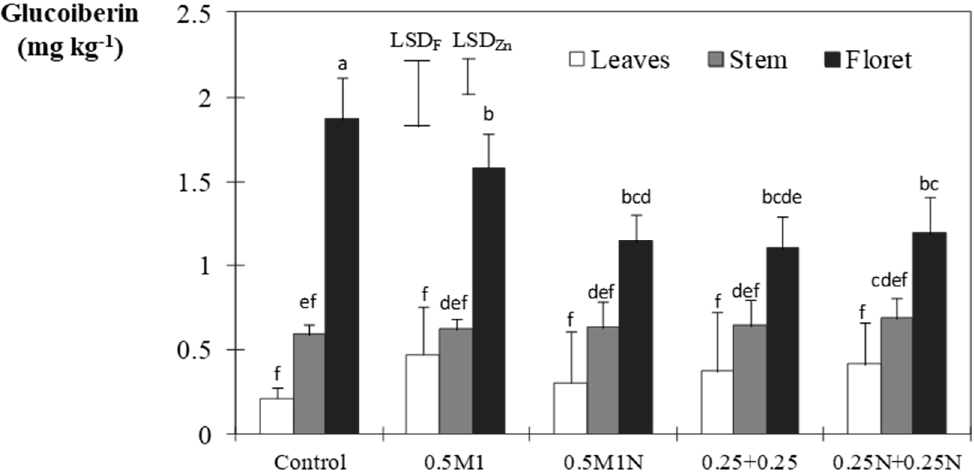
Figure 3. Glucoiberin ± standard error of the mean. Vertical bars represent LSD ( p < 0.05) for comparison. LSD F : same broccoli fraction; LSD Zn : same Zn treatment. Different letters represent a significant difference at the p < 0.05 level for each broccoli fraction and Zn treatment.